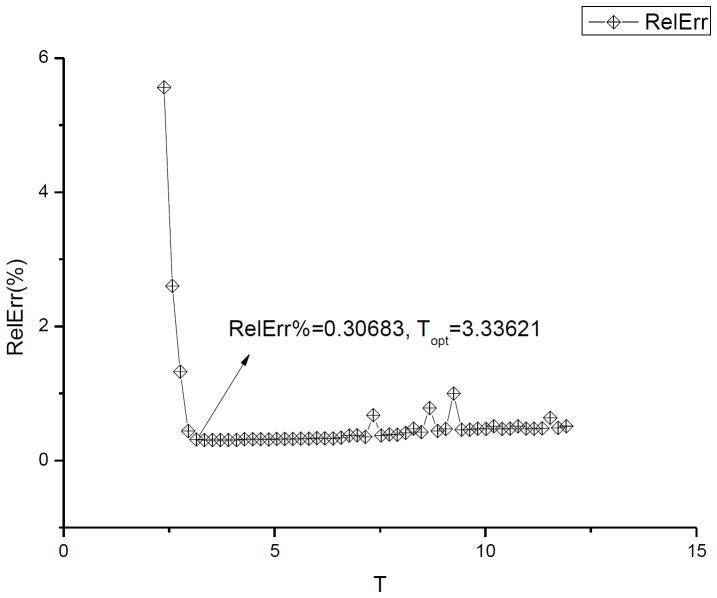
The procedure of the obtaining T
opt.This plot explains the procedure of the finding the T
opt from expression [8]. It confirms also that the desired minimum is located in the interval [0.5T
max, 2T
max]. For all cases at the fixed value of K = 16 the value of the relative error does not exceed 1%.